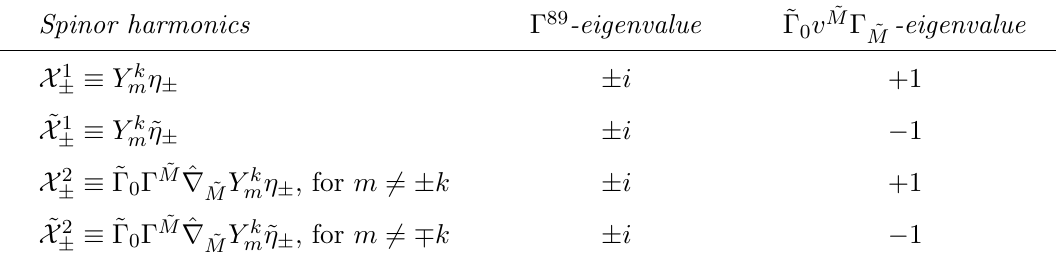
Table 1 . Spinor harmonics basis and corresponding